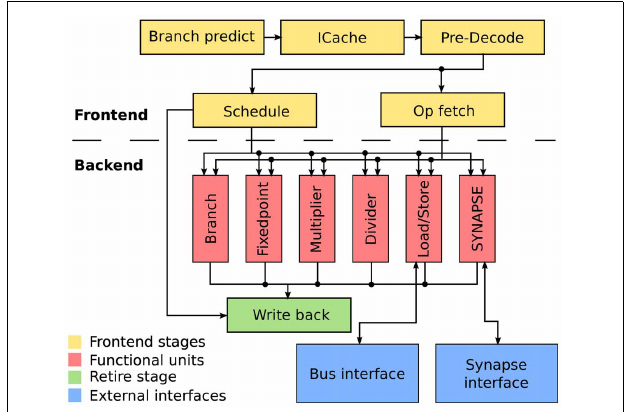
FIGURE 2 | Micro-architecture of the embedded plasticity processor. The design is separated into frontend and backend. The frontend takes four clock cycles to decode instructions and issue them in-order to the applicable functional unit. The functional units take a minimum of two cycles. Writing the result back to the register file takes another cycle. Input/output operations are performed through a bus interface served by the load/store unit and a specialized interface to the synapse